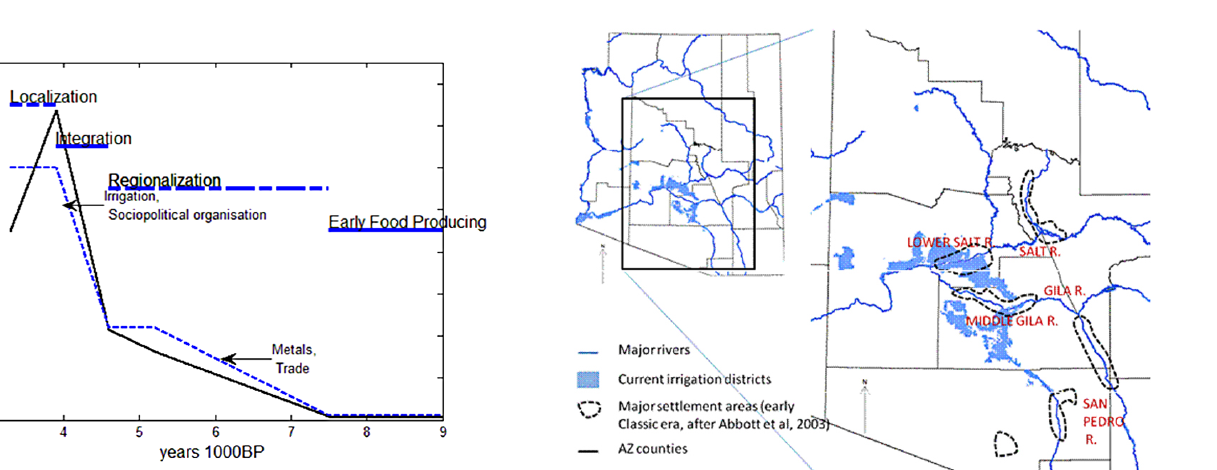
Fig. 10. Overview of Hohokam settlements in the Salt and Gila River areas (Early Classic area). Data source: Arizona State Land Department, Arizona Land Resources Information System, Major Rivers & County; Arizona Department of Water Resources, Irriga- tion districts; 11 July 2013 in Arizona Geospatial Data and Maps